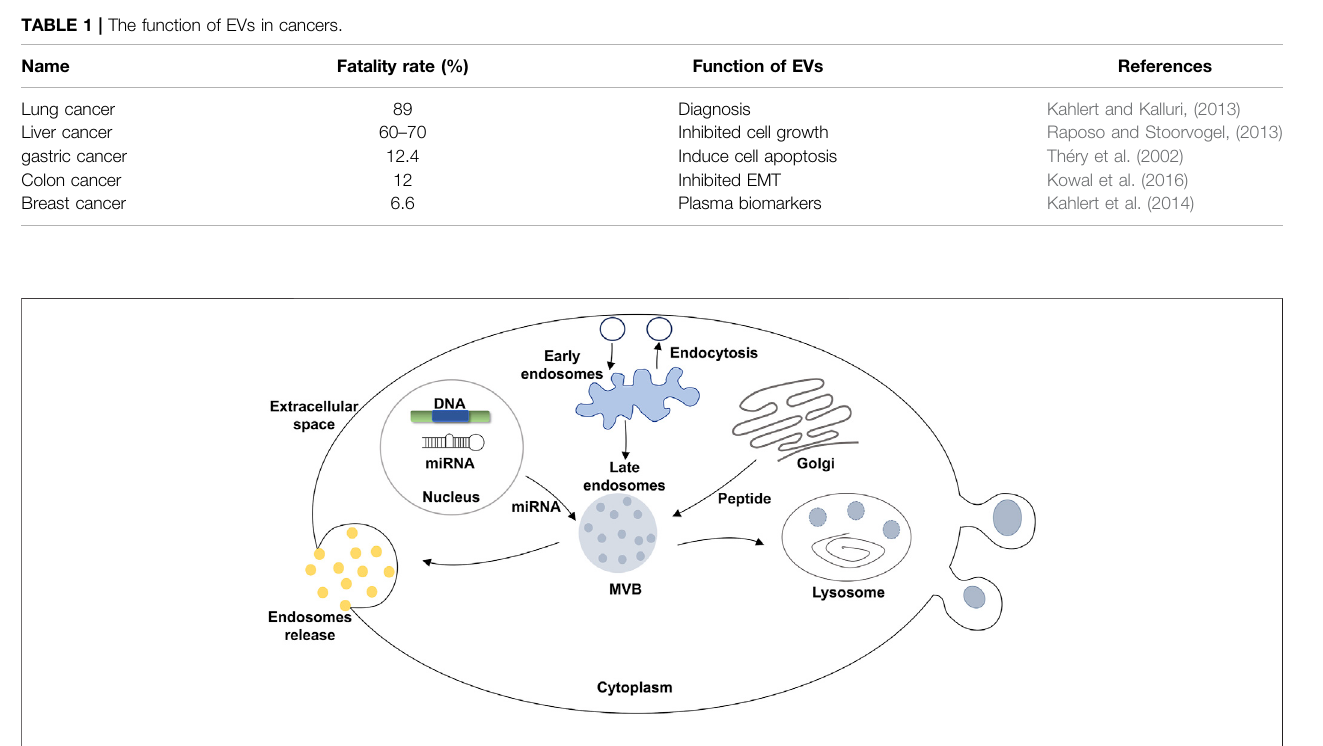
FIGURE 1 | Formation of